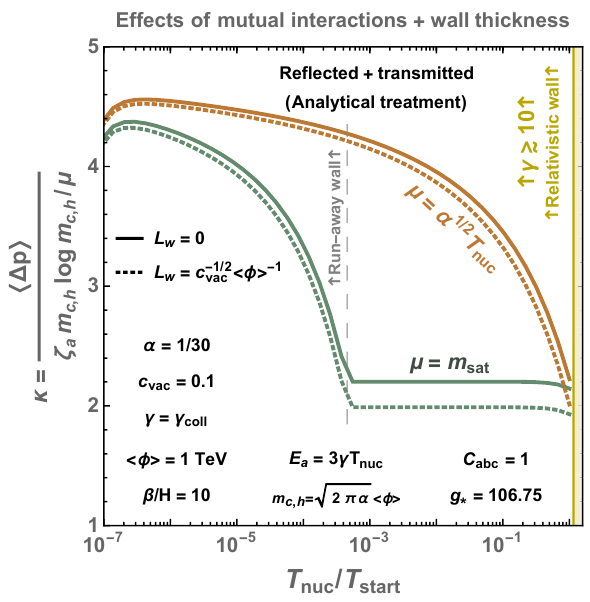
Figure 3 . Analytical average exchanged momentum h ∆ p i = h ∆ p i + h ∆ p i , where the resummed R T pressure P is proportional to γ T 3 h ∆ p i , see eq. (6.4). For the solid lines we used the full nuc LL analytical expressions in eqs. (4.11) and eqs. (4.13), which assumed negligible wall thickness, and for the dotted ones we use the full numerical result eq. (B.13) for a finite wall thickness L w = c − 1 / 2 vac h φ i − 1 . The IR cut-off µ is set to (brown lines) the thermal mass α 1 / 2 T nuc and to (green